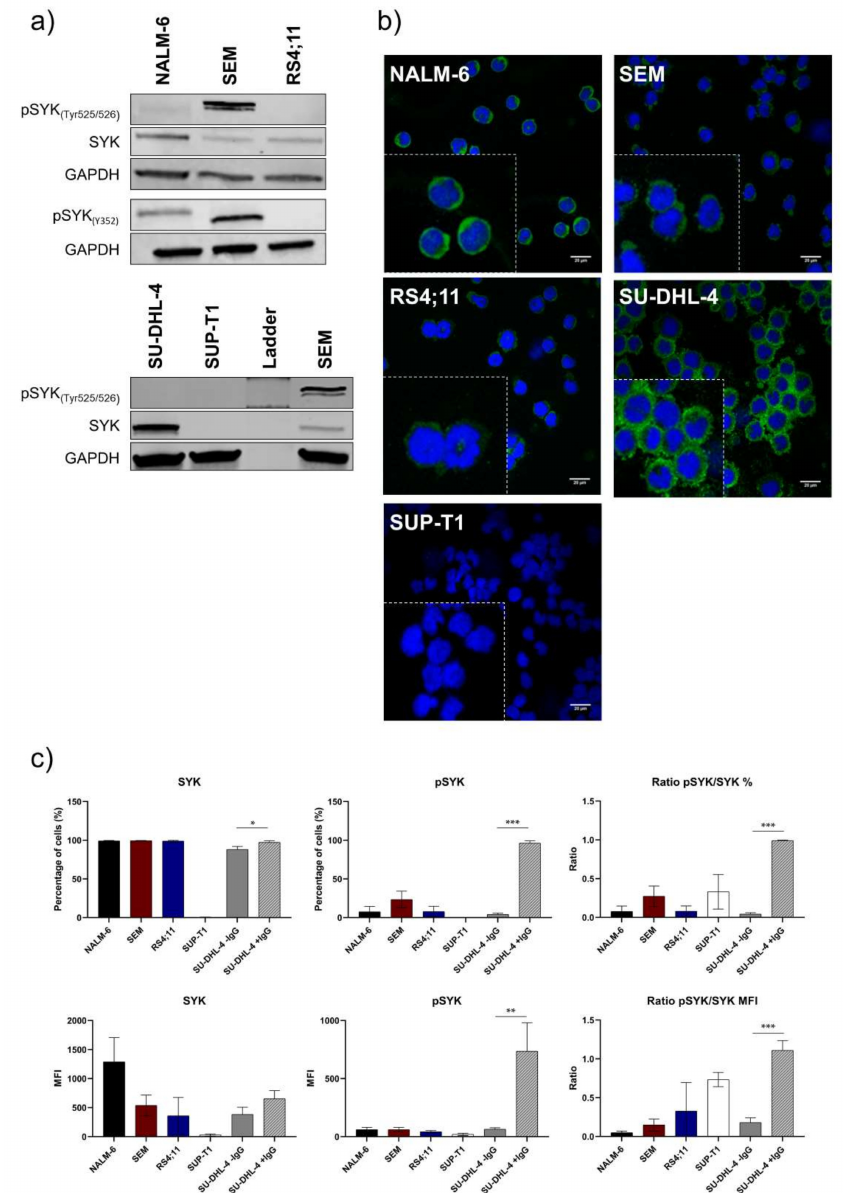
Figure 1. Basal characterization of SYK and pSYK expression in B-ALL cell lines. Characterization of basal SYK protein expression in B-ALL cell lines. Highest SYK expression was observed in pre-B-ALL NALM-6, while pro-B-ALL SEM showed the highest pSYK expression. ( a ) SYK and pSYK expression of two phosphorylation sites (Tyr525/526 and Y352) under non-stimulating conditions in the B-ALL cell lines and the DLBCL cell line SU-DHL-4 as well as the T-cell lymphoma cell line SUP-T1 (positive and negative control, respectively). ( b ) Immunofluorescent staining of SYK in the B-ALL cell lines and control cell lines (composite image of the Alexa Fluor Plus 488 green-labeled SYK and blue DAPI-stained nucleus) by confocal microscopy. ( c ) Intracellular staining of SYK-FITC and pSYK(Y348)-PE by flow cytometry in unstimulated B-ALL cells showing SYK and pSYK expression based on percentage (%) and mean fluorescent intensity (MFI) (SUP-T1 cell line as the negative control and IgG-stimulated SU-DHL-4 as the positive control). The mean fluorescence intensity (MFI) of all cell lines is expressed in arbitrary units (AU). Data are presented as the mean ± SD. Statistical significance was calculated by t -test and displayed as * p < 0.033, ** p < 0.002, *** p < 0.001 ( n ≥ 3). Furthermore, intracellular flow cytometry demonstrated almost entirely SYK-positive cells for all tested cells except for the negative control SUP-T1. Comparison of the